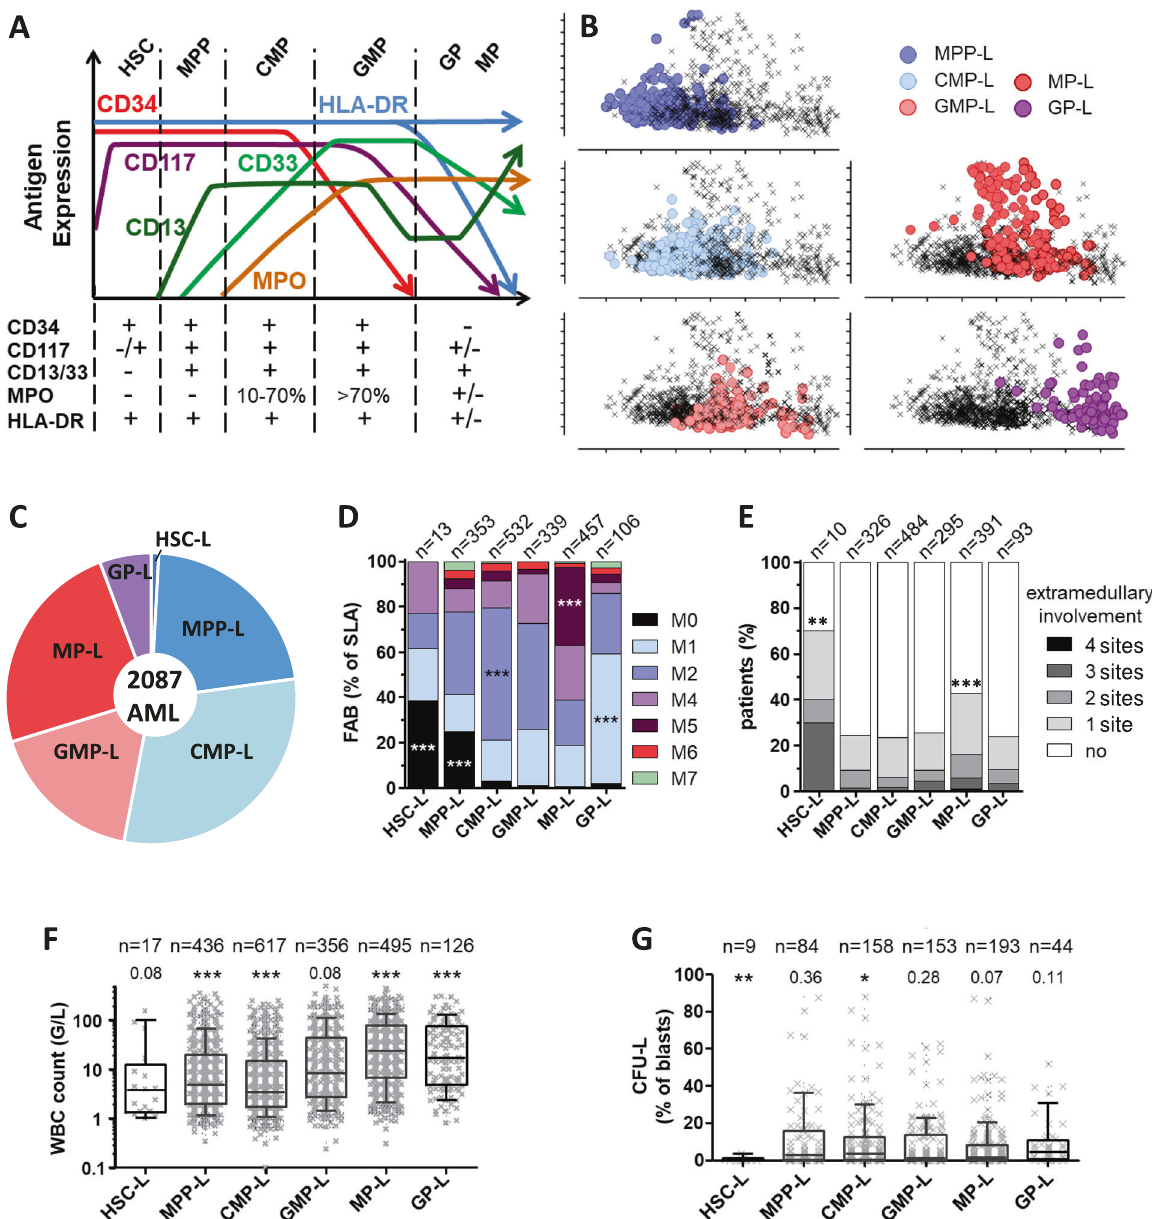
Fig. 1 Phenotypic and clinical identi fi cation of AML subgroups. A Model of the relative percentage of myeloid marker expression over the course of normal HSPC differentiation. The SLA is de fi ned by the combination of expressions of fi ve myeloid markers plus HLA-DR to differentiate GP-L (HLA-DR + ) and MP-L (HLA-DR − ); + ≥ 20% of blasts; − <20% of blasts; + / − marker can be positive or negative. B Principal component analyses of 945 AML using the percentage of AML blasts expression of 16 markers by fl ow cytometry (CD4, CD7, CD13, CD33, CD117, MPOc, CD34, HLA-DR, CD56, CD64, CD38, CD65, CD16, CD14, CD11b, CD123). AML patients were classi fi ed according to their SLA as detailed in ( A ). C Pie chart of 2087 AML from TUH cohort segregated according to their SLA. D FAB classi fi cation according to SLA in the TUH cohort. Fisher ’ s exact test compared FAB classi fi cation in one SLA to all others. E Extramedullary involvement in SLA (see Table 1 for details). F Boxplots of leukocytosis at diagnosis in TUH cohort. G CFU-L in TUH cohort. Statistical analysis was performed comparing one SLA to all others (Mann – Whitney using clinical data and clonogenic properties as surrogate markers of migration (extramedullary involvement) and proliferation (leucocytosis) capacities. Cell migration capacities and emigration from the bone marrow are known to be features acquired during differentiation [30]. As a result, the extramedullary disease was signi fi cantly more frequently observed in the MP-L group and surprisingly in the low HSC-L group (Fig. 1E). In detail, patients with GMP-L, GP-L, and MP-L displayed a higher rate of lymph node enlargement and leukemic gingival in fi ltration (Table 1).